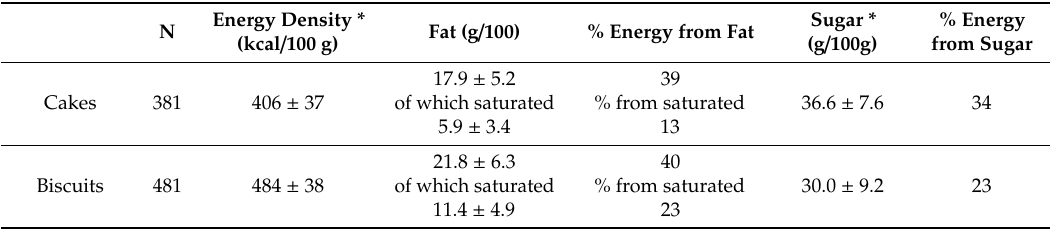
Table 1. Energy density, total and saturated fat and sugar content (mean, SD), and their respective percentage energy contribution to overall product energy in cakes and biscuits.